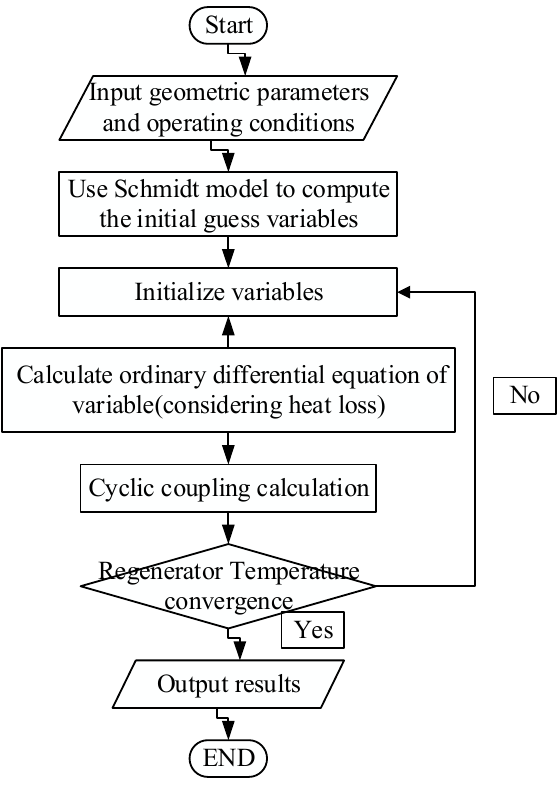
Figure 5. Flow chart of FPSC_NINT code calculation.